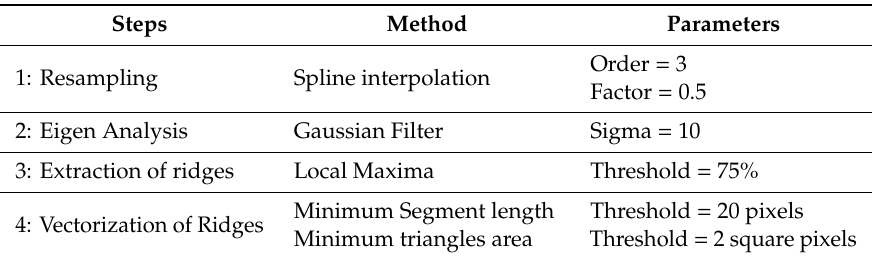
Table 3. Steps for DEM analyses of feature extraction.